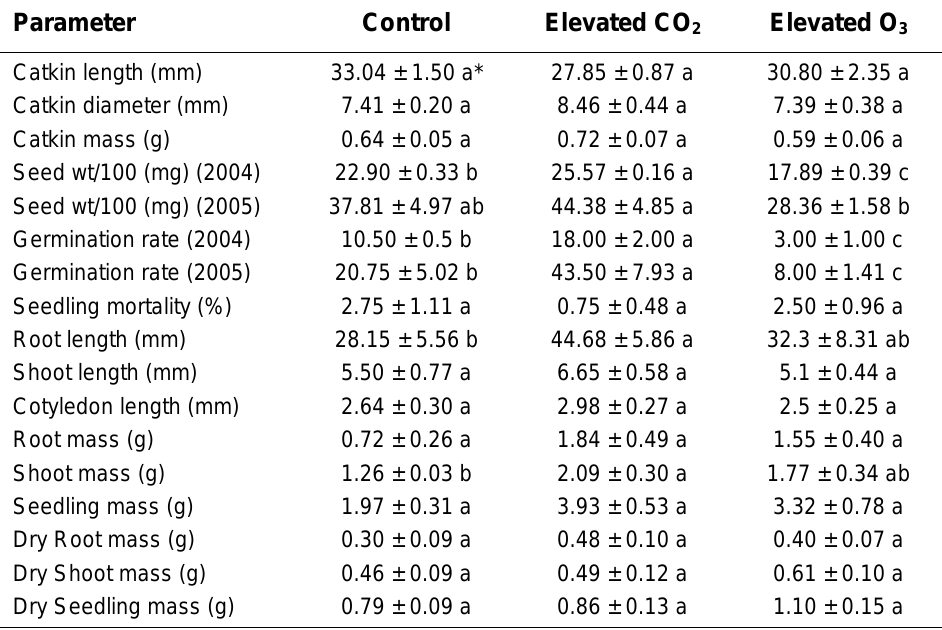
Characteristics (Mean ± SE) of Paper Birch Catkins, Seeds, and Seedlings from Seed or O , Compared to that Produced in Ambient Conditions Produced under Elevated CO 2 3 Parameter